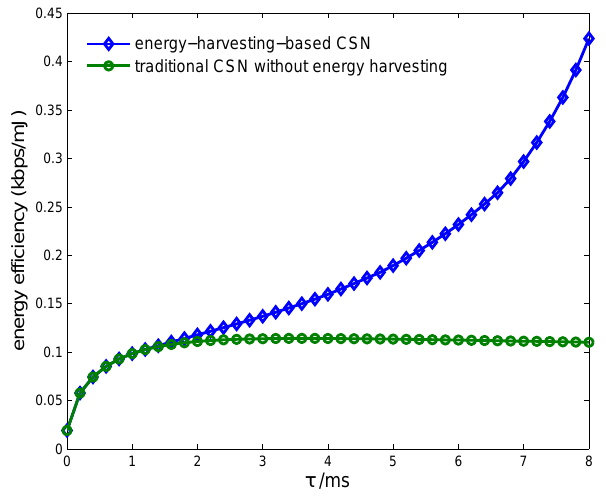
Figure 16. Energy efficiency vs. cognitive sensor network model with spectrum sensing